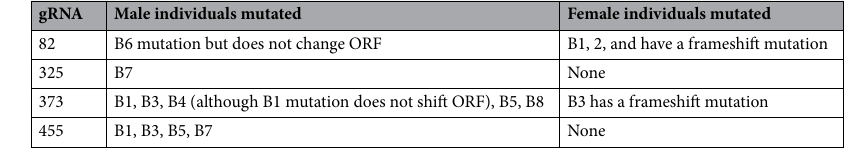
Table 2. Tabulation of mutations and phenotypes. Overall: 10/11 animals microinjected with Cas9/gRNAs had mutations (91%), 2 of the mutations did not disrupt the open reading frame (20%), and 4 of the 10